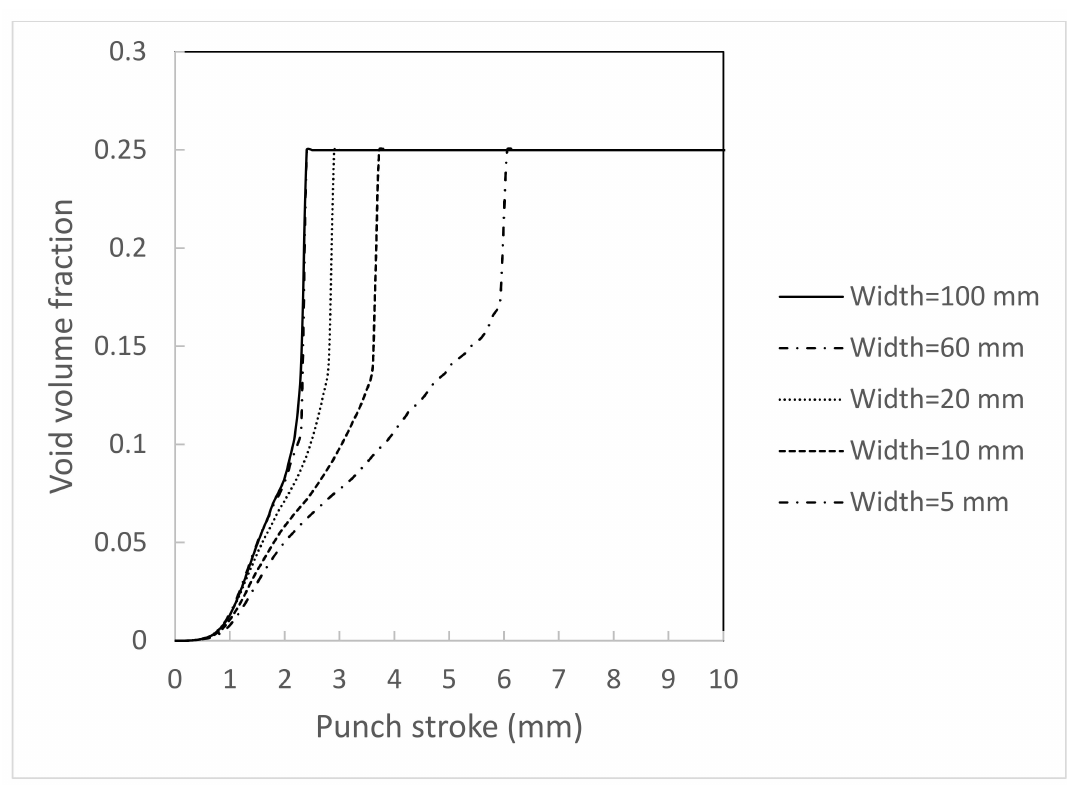
Figure 10. Void volume fractions at point A in metal sheets with various